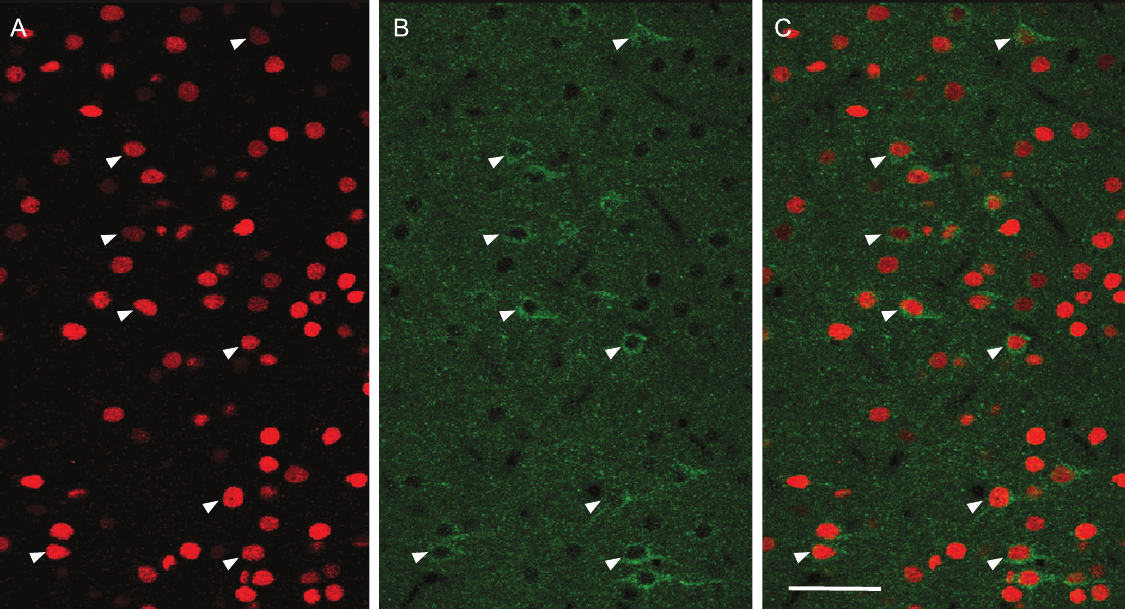
Figure 2. Colocalization of c-Fos and GluT(EAAC1) in pyramidal cells in layer V of mPFC. Representative examples of c-Fos (red, A) and GluT(EAAC1) (green, B) immunostaining and their colocalization (C) in layer V of PrL in the mPFC of visual/HDB stimulated rats. Arrowheads point to examples of colocalization of c-Fos + cells and pyramidal cells. Note that the majority of pyramidal cells were immunoreactive for c-Fos, whereas only a small proportion of c-Fos + cells were stained for GluT(EAAC1). Abbreviations: ChAT: choline acetyltransferase; GluT(EAAC1): glutamate transporter; mPFC: medial prefrontal cortex; PrL: prelimbic cortex. Scale bar: 50 m m. doi:10.1371/journal.pone.0022543.g002 PLoS ONE |